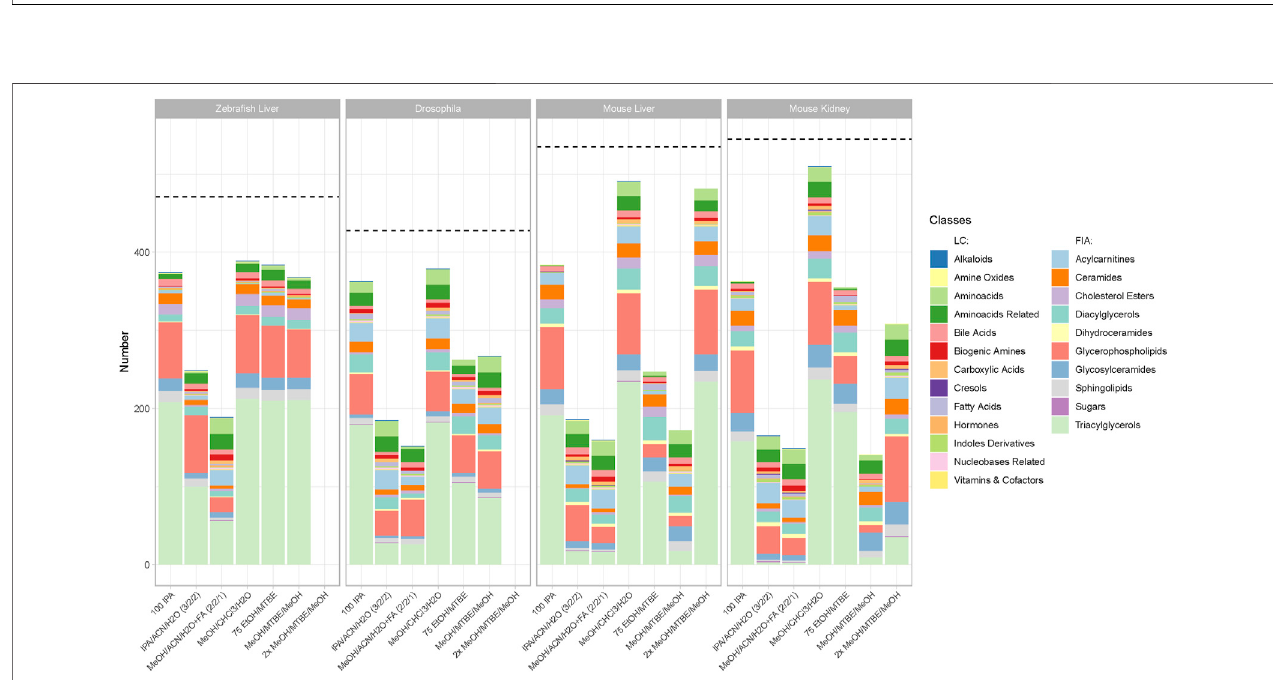
FIGURE3| Numberofmetabolitesperclasswiththehighestconcentrationperextractionprotocolacrossallsampletypesandmodelorganisms.Metabolitesthat appear in the bar chart are only counted when they produce the highest or a non-signi fi cantly lower concentration ( p > 0.05, see Material and Methods) than another tested extraction protocol. The dotted line shows the number of detectable metabolites for each sample type. Indicated by color are the different metabolite classes measured. The legend is categorized between the LC-MS/MS and FIA-MS/MS measurements. A list of the metabolites per extraction protocol can be viewed online in “ MetaboExtract ” . Of note, the metabolite classes that were best suited for a single extraction protocol are depicted in Supplementary Figure S4 .